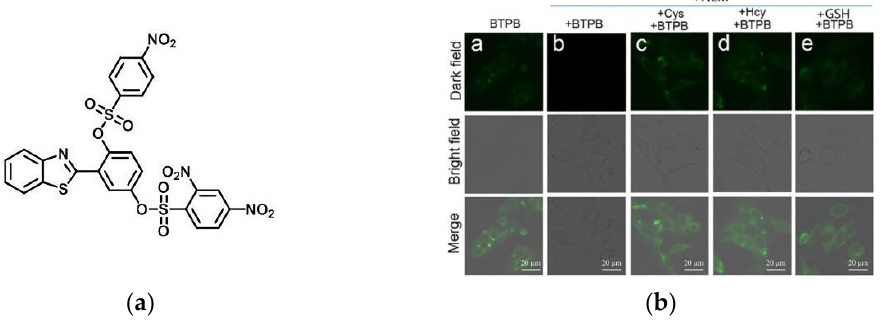
Figure 24. ( a ) The structure of probe BTPB; ( b ) Fluorescence imaging of biothiols in living HepG2 cells. Reproduced with permission from [105]. Copyright 2019 Elsevier B.V.